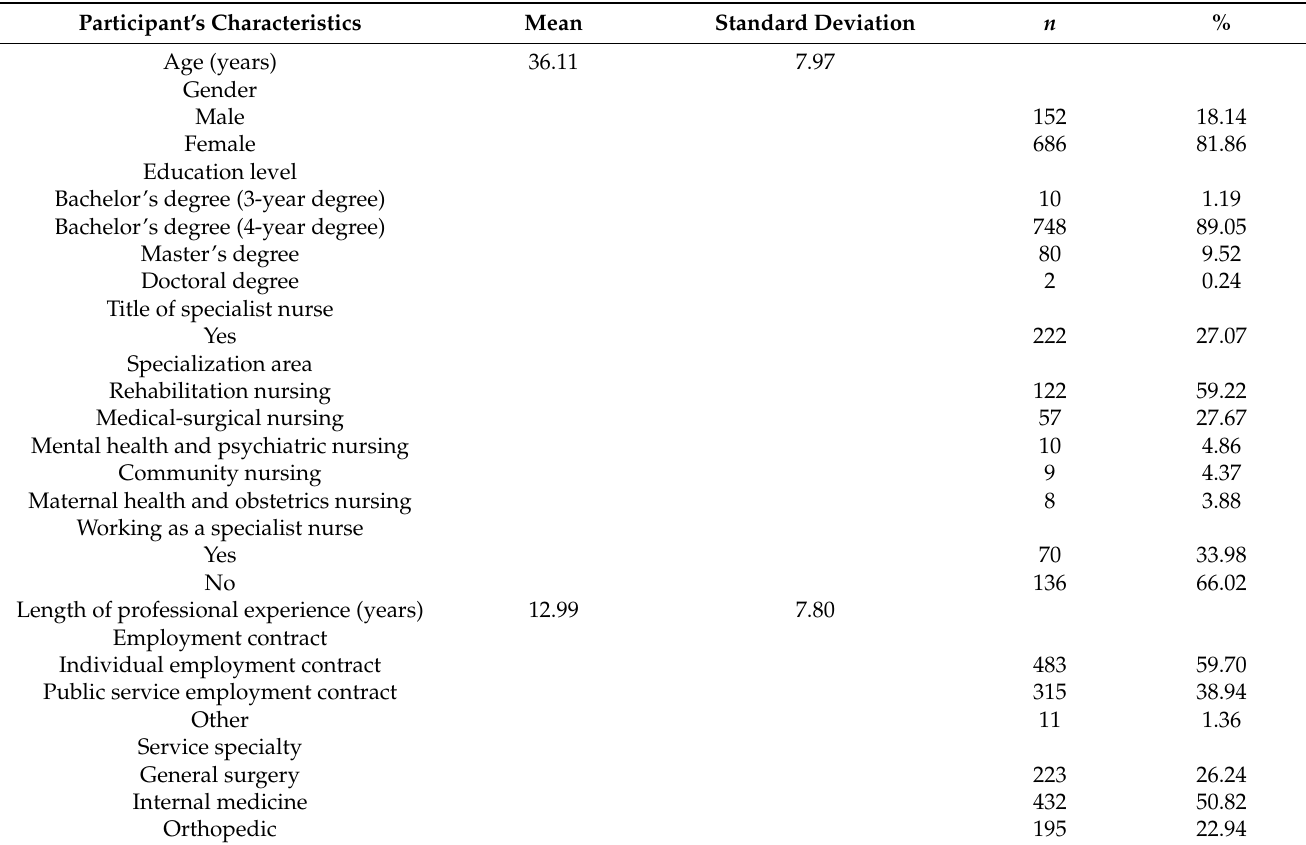
Table 1. Participant’s